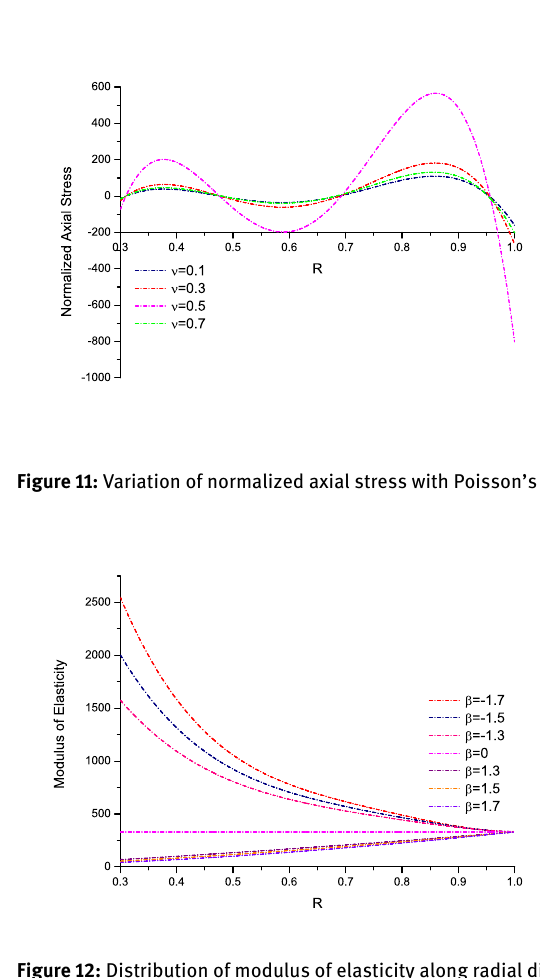
Figure 14: Distribution of thermal expansion coefficient along radial direction for different values of